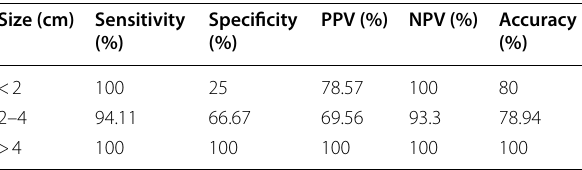
Table 2 Diagnostic indices of USG-FNAC in different thyroid swellings according to their size